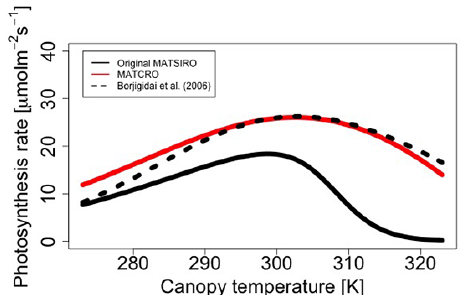
Figure 4. Relationship between the leaf area index (LAI) and crop height (black curve: h gt = h aa L h ab ; red curve: h gt = h ba L h bb ).